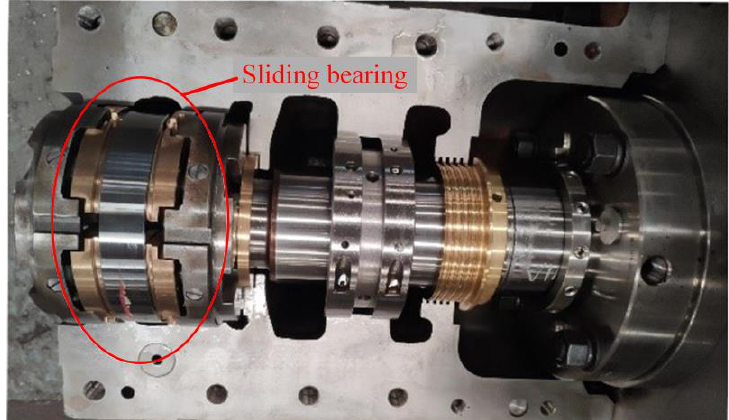
Figure 5. Real structure of the studied sliding bearing. Table 1. Dynamic characteristic coefficients of the sliding bearing.